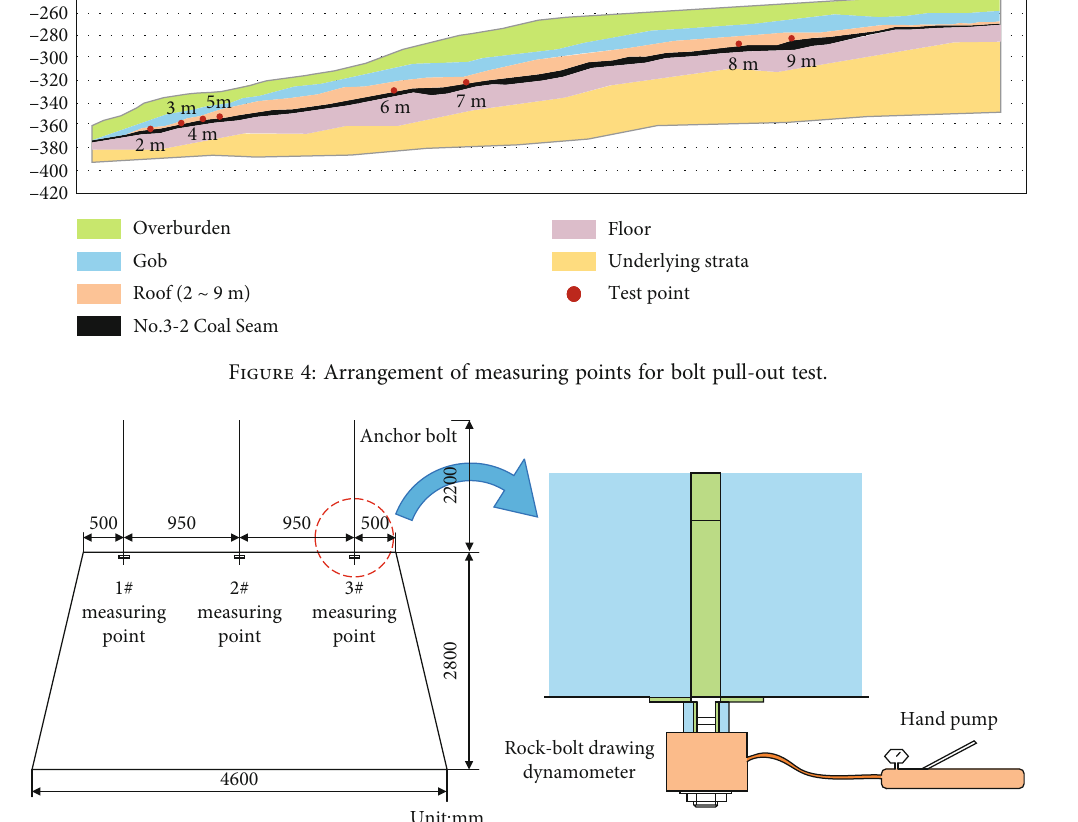
Figure 5: Installation position of test rock bolt of the